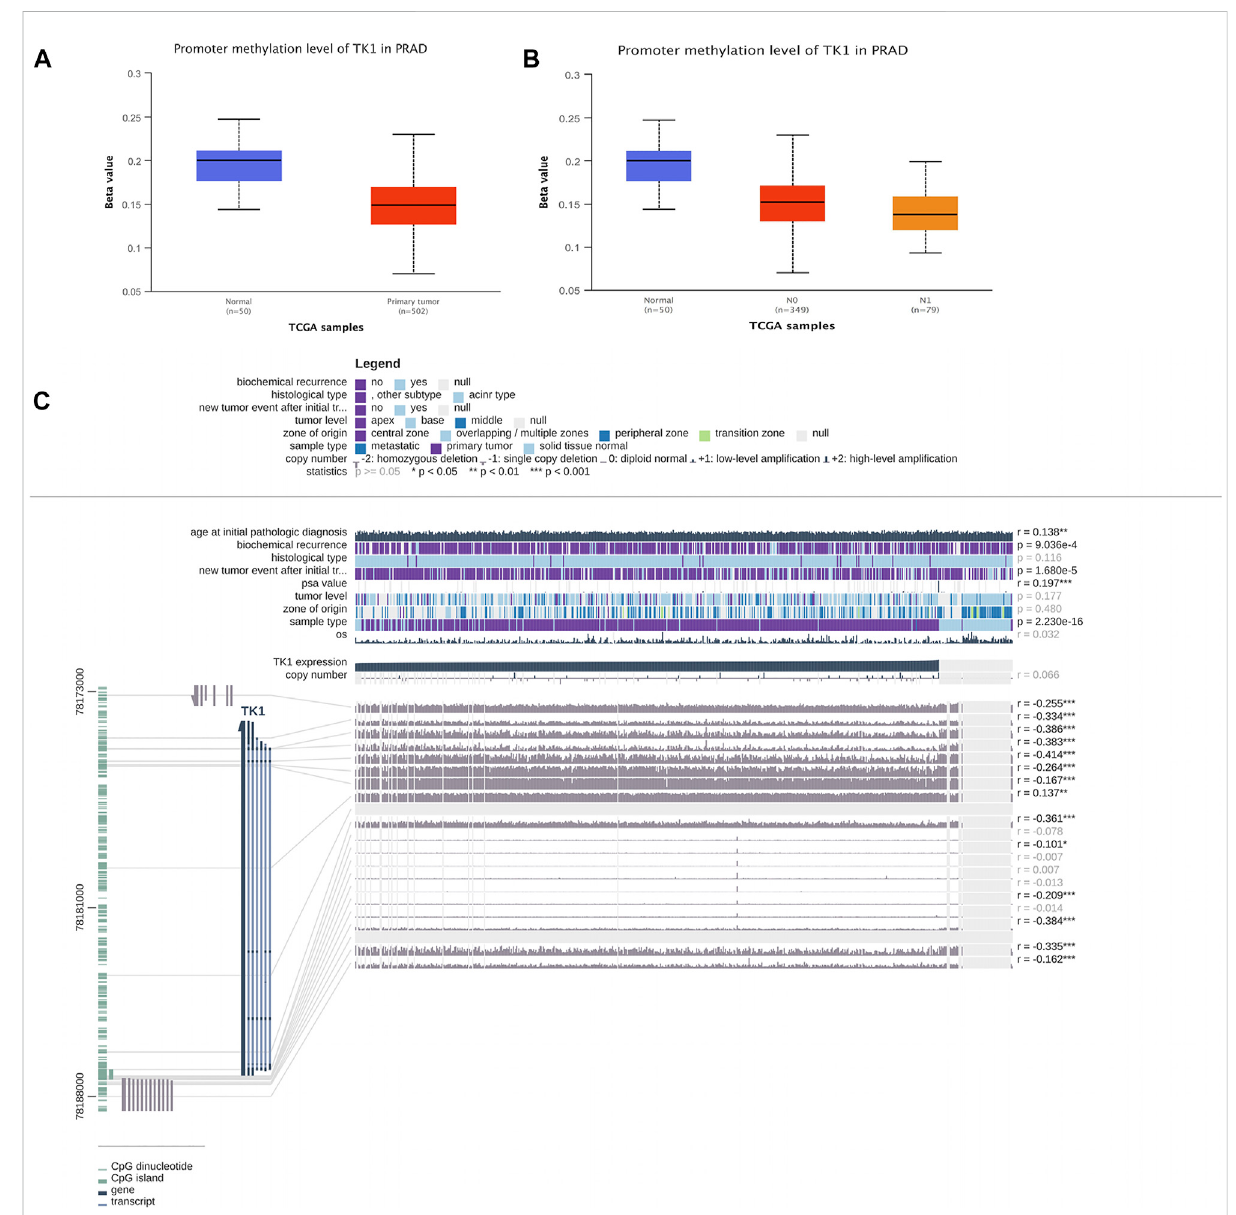
FIGURE 3 DNA methylation level of TK1 in PCa. (A) UALCAN data resource showing promoter methylation levels of TK1 in normal and PCa tissues. (B) UALCAN data resource offering promoter methylation levels of TK1 in PCa tissues with different nodal metastasis statuses. (C) Relationship between TK1 expression and PCa and methylation around CpG islands and promoter